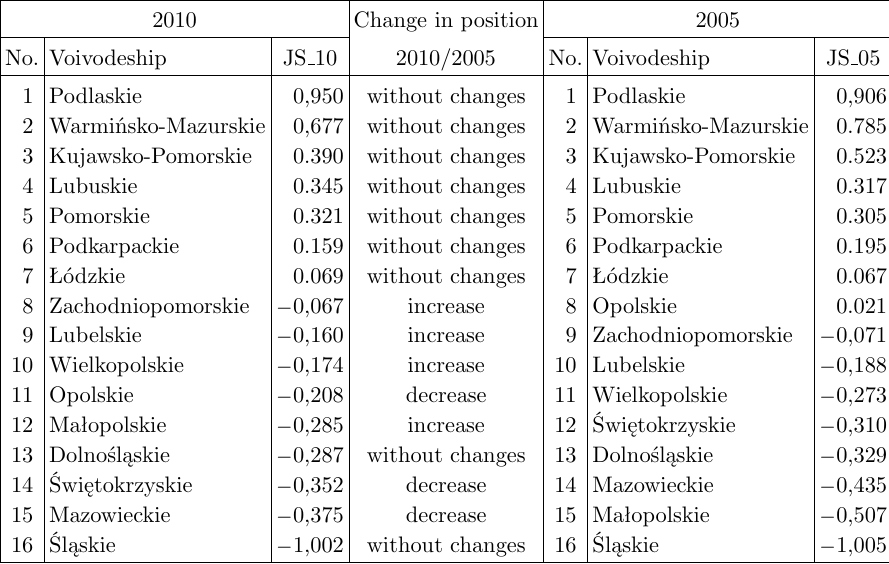
Ranking of Polish voivodeships in terms of synthetic index of environmental quality in 2010 (JS 10) and in 2005 (JS